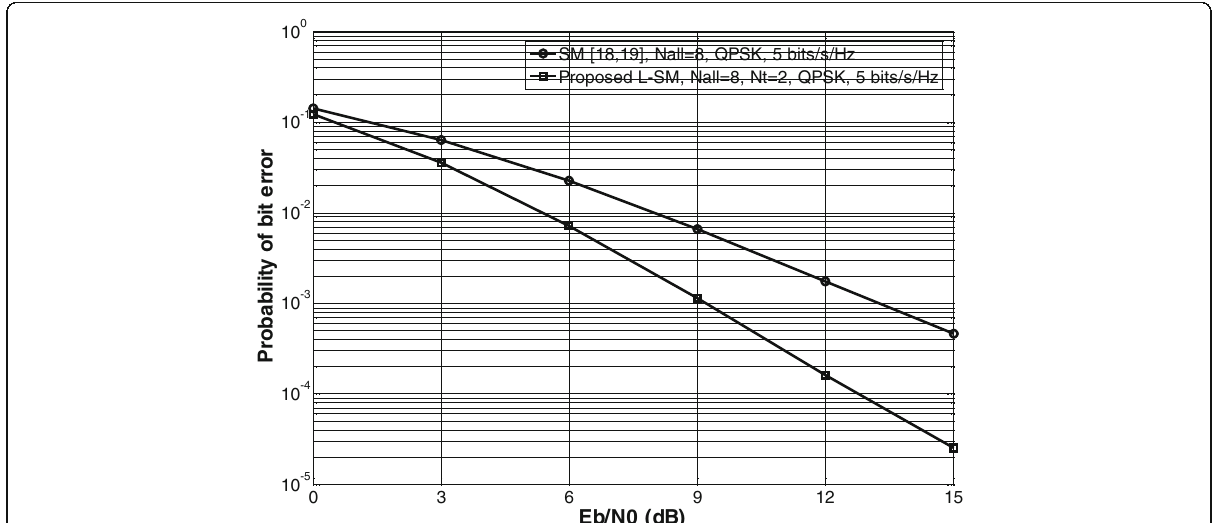
Fig. 6 Performance comparison of SM and proposed L-SM schemes with N r = 2 for 5